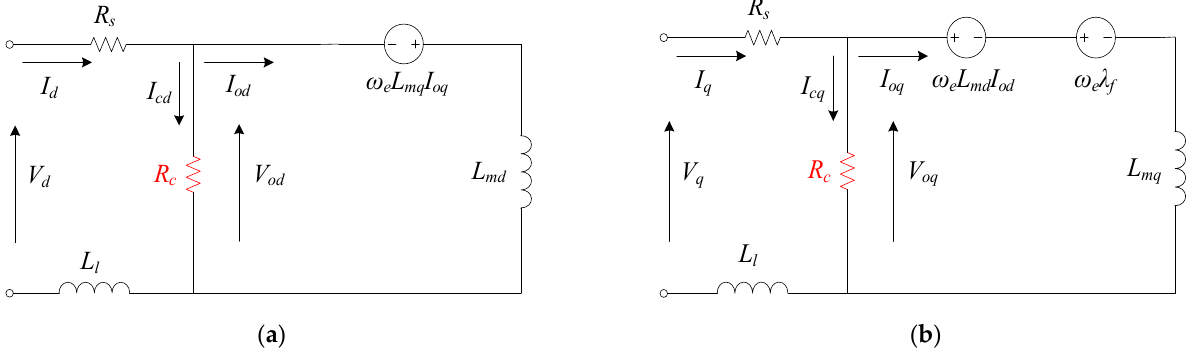
Figure 10. ECM of PMSMs with predictable core loss: ( a ) d -axis; ( b ) q -axis [19]. Nevertheless, in the opinion of the authors of this paper, the ECM of PMSMs, considering the leakage inductances under the d- and q- axis reference frame, should be modified, as shown in Figure 11, and L l is the leakage inductance per-phase. The flux linkage generated by phase windings can be expressed in terms of the leakage linkage and the magnetizing linkage. However, the leakage flux only links the stator winding itself and does not contribute much to the core loss of the stator. Therefore, the magnetizing flux linkages, in which the equivalent core loss resistances are paralleled, should exclude the leakage inductances.